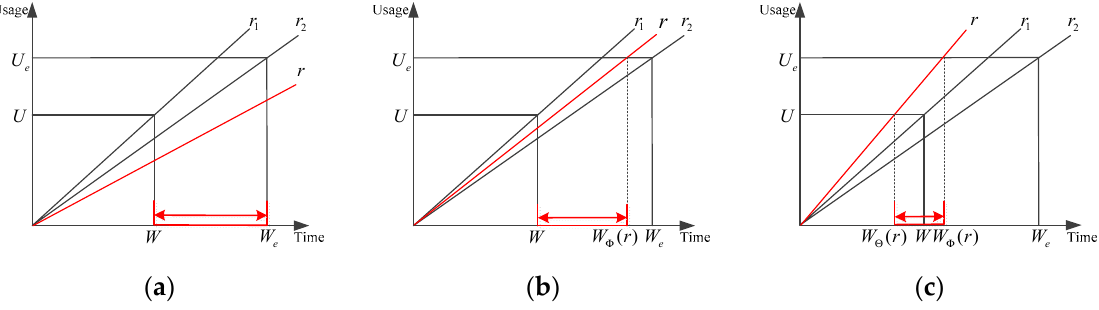
Figure 3. Schematic diagram of EW period when r